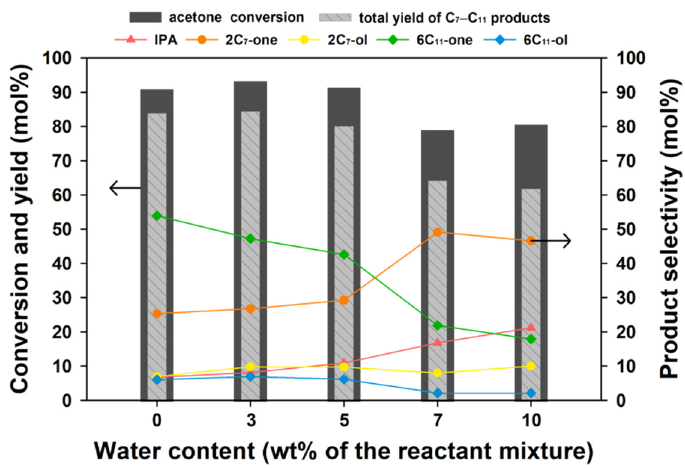
Figure 9. Effect of water on the catalytic performance of 5 wt % Cu/Pr 2 Zr 2 O 7 in the cross-coupling of acetone with butanol. Reaction conditions: 20 g reactant with the butanol/acetone mole ratio of 2, catalyst 1 g, 240 °C, and 20 h.